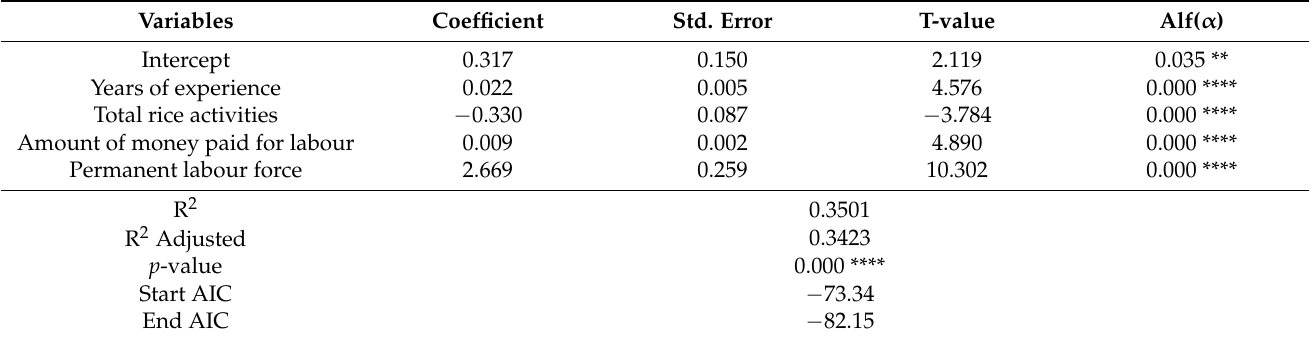
Table 7. Multiple linear regression to predict rice production in the Ch ó kw è Irrigation